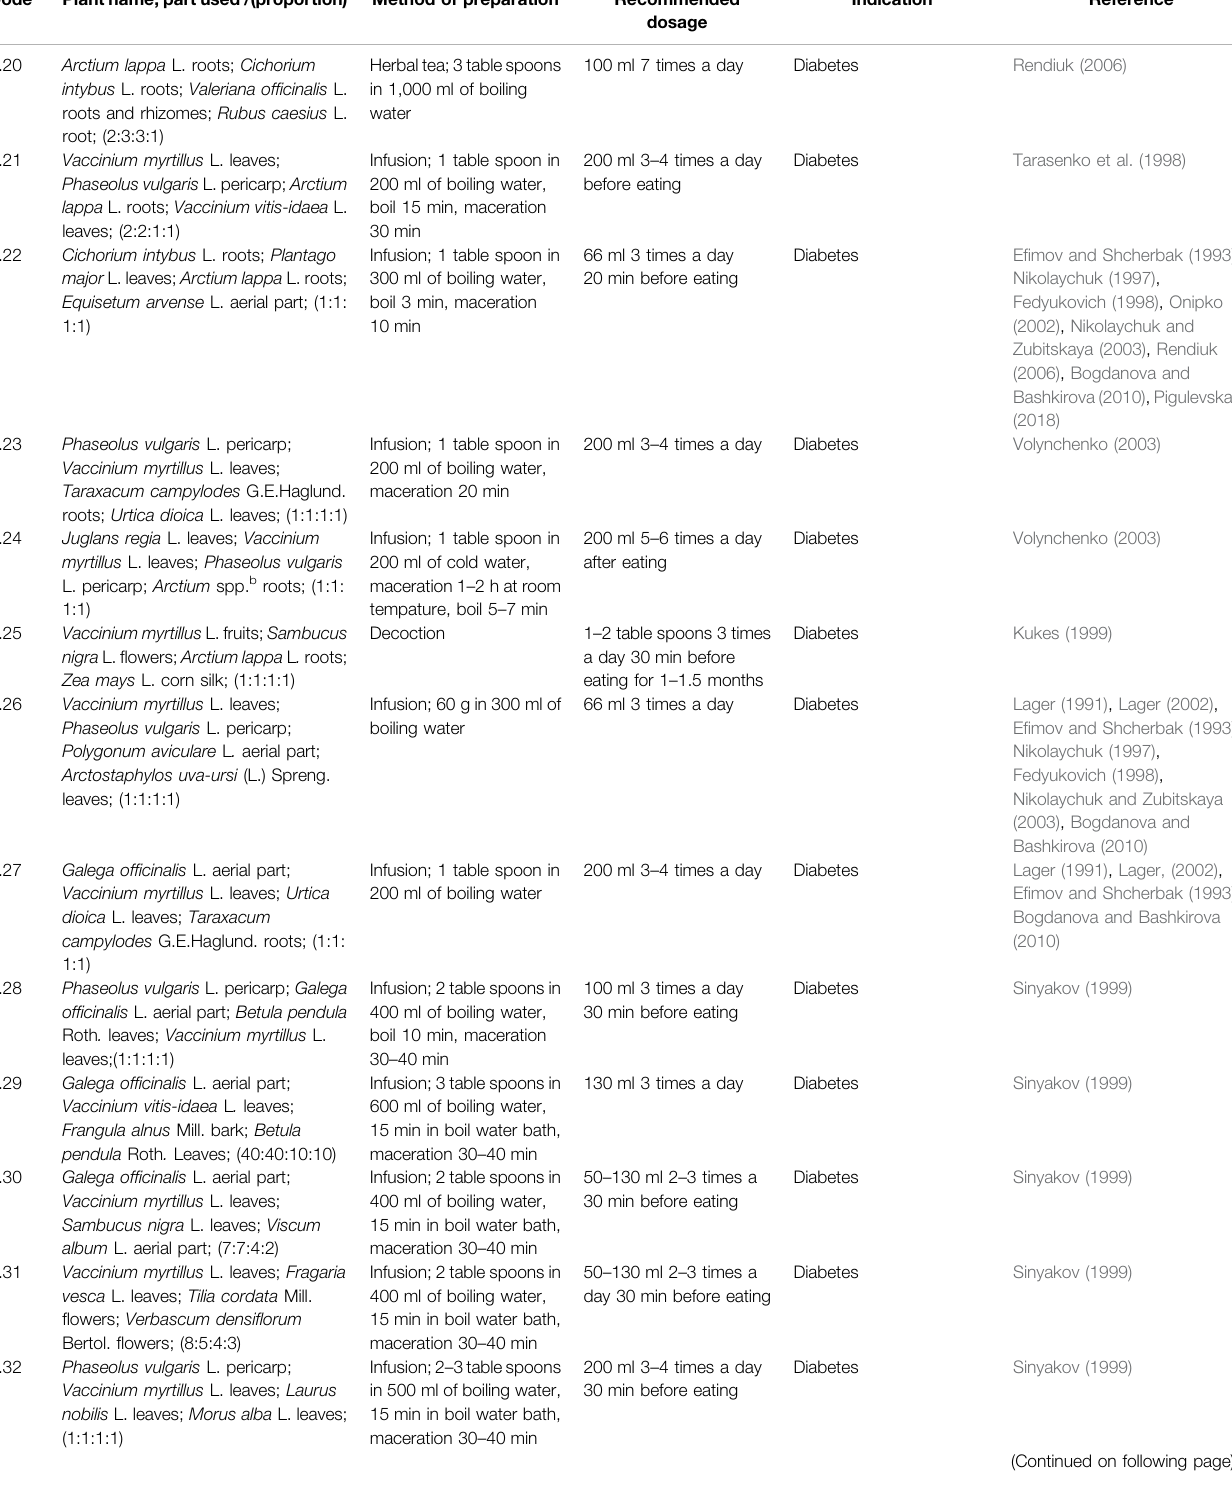
TABLE 1 | ( Continued ) The list of medical species used for the management of diabetes and related disorders in Russia. Code a Plant name, part used /(proportion) Method of preparation Recommended